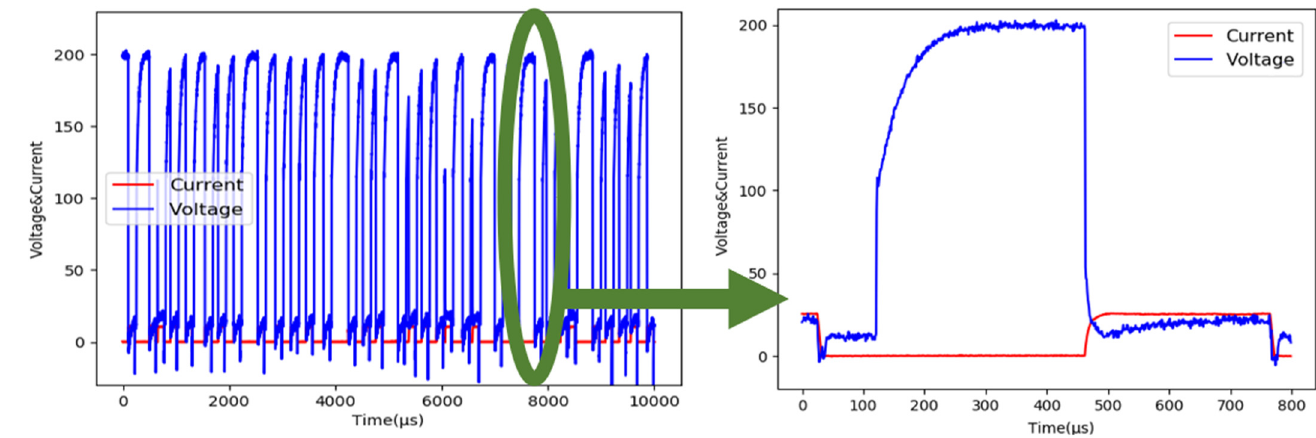
Figure 10. EDM Machine and sensing configuration.